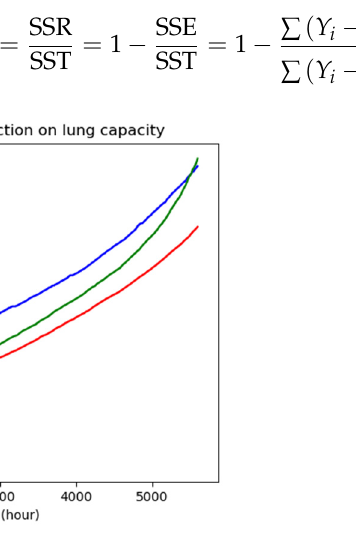
Figure 3. Recommendation prediction on lung capacity.